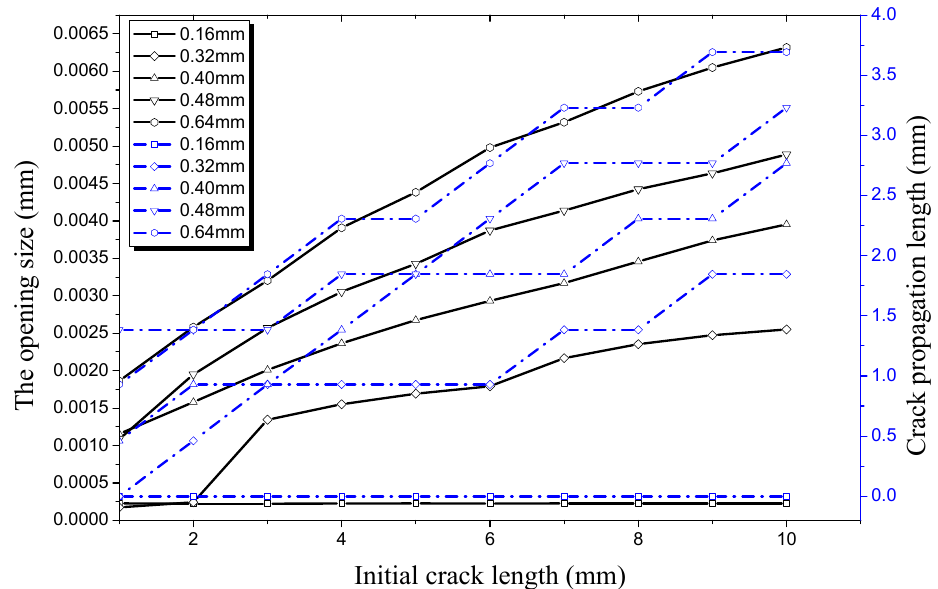
Figure 22. Relationship between longitudinal crack propagation length and initial crack length on the inner surface, and relationship between longitudinal opening size and initial crack length on the inner surface, both under an internal pressure of 35 MPa.